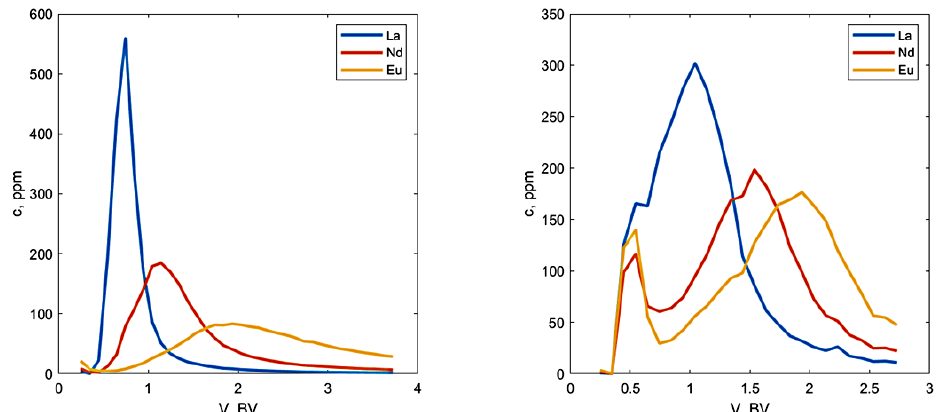
Figure 7. Chromatogram with feed pH = 9.08 ( left ) and feed pH = 12.20 ( right ) (resin = IRA-410; T = 298 ± 2 K; flowrate = 2.98 BV/h; feed pulse = 0.025 BV; acid concentration = 10 mM).